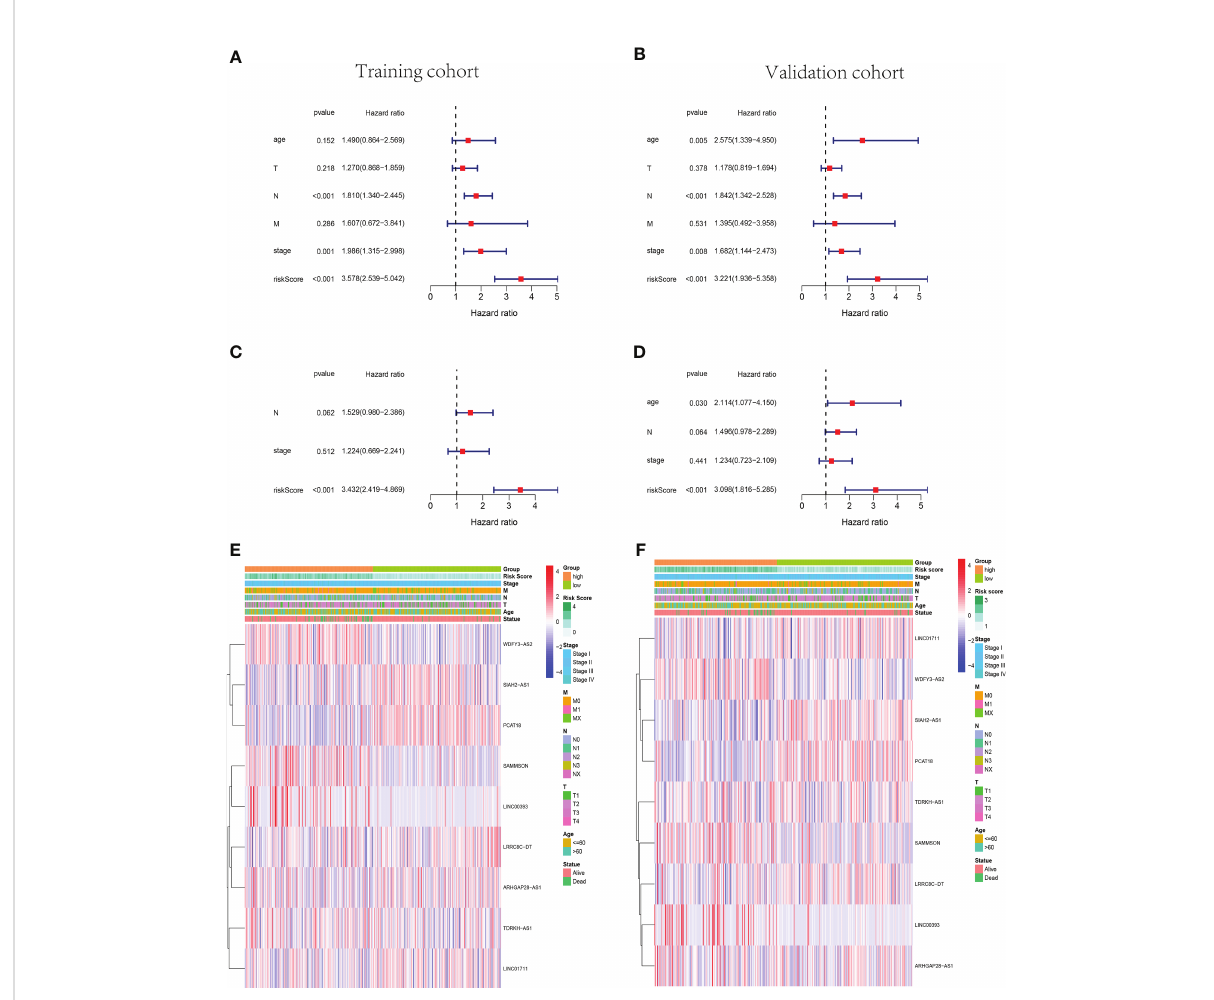
FIGURE 4 The cuproptosis-related lncRNA risk score was identi fi ed as an independent prognostic factor for patients with BC. Univariate and multivariate Cox regression analyses of the signature in the training (A, C) and validation (B, D) sets. Clustering analysis heatmaps indicate the expression levels of the nine identi fi ed cuproptosis-related lncRNAs and the clinicopathological characters of the respective patients with BC in training (E) and validation (F) groups (stage, AJCC tumor stage I/II/III/IV). lncRNA, long non-coding RNA; BC, breast cancer; AJCC, American Joint Committee on